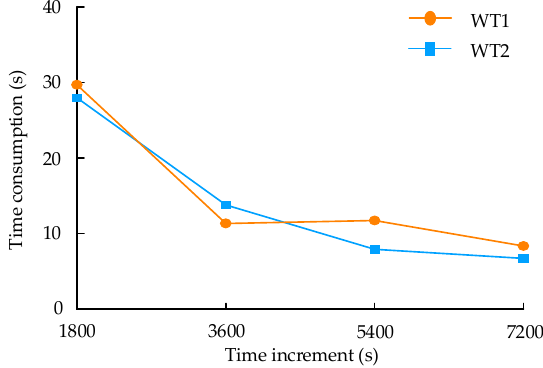
Figure 11. Time consumption at different time increments.